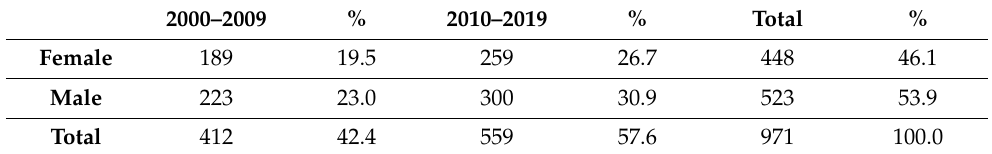
Table 1. Time course of the frequencies of infantile supracondylar humerus fractures in girls and